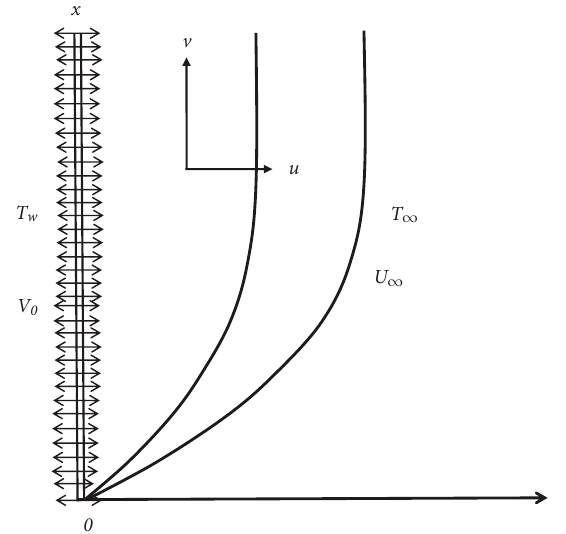
Figure 1: The fl ow coordinate system and the fl ow con fi